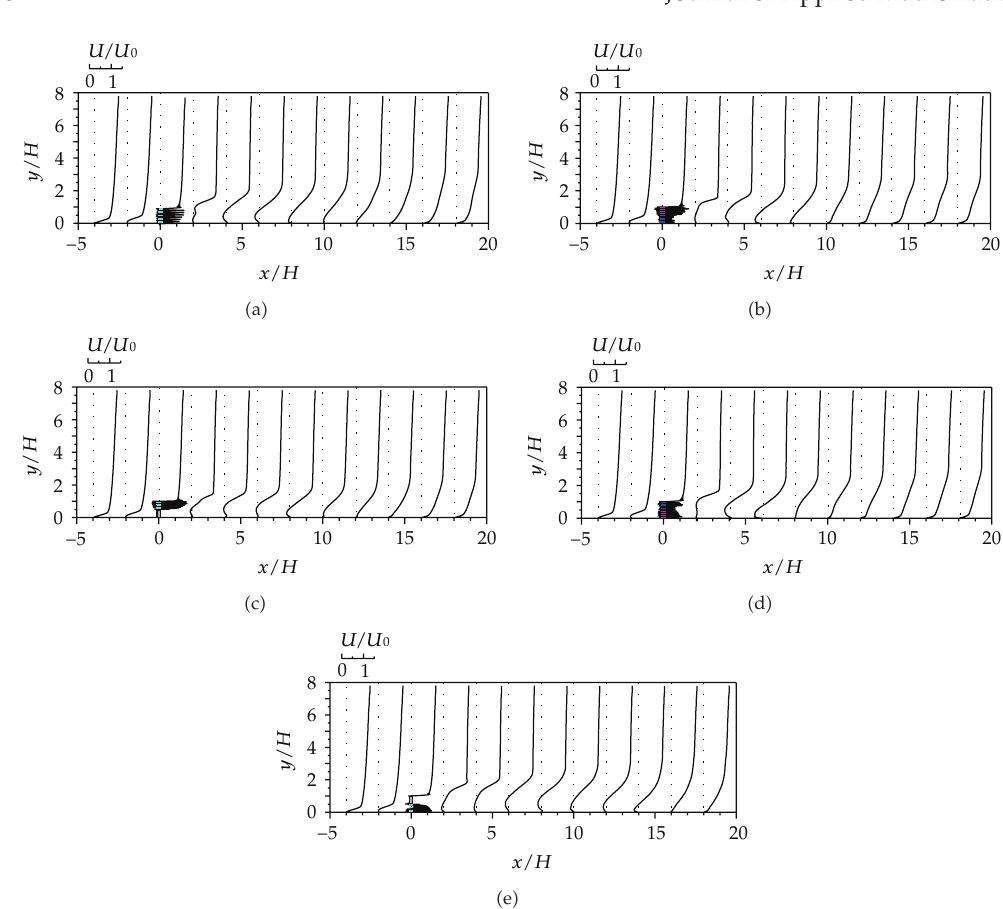
Figure 8: Variations of calculated mean streamwise velocity profiles around various porous fences.